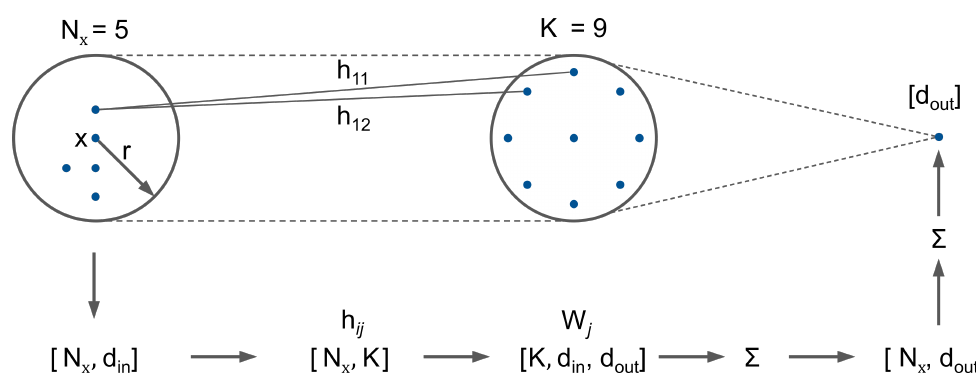
Figure 2. Processing of the center point x with d out kernel point filters. Based on [8].